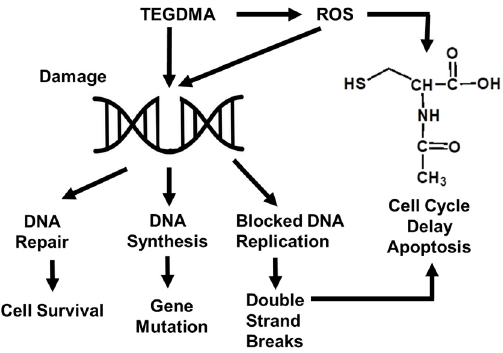
Figure 5. Damage to cell function by monomer HEMA released by resin restorations.